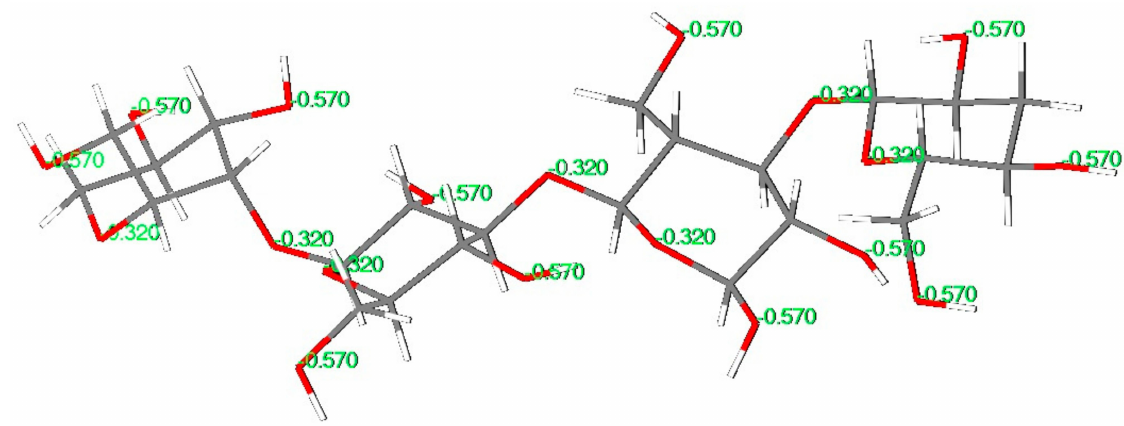
Figure 9. Distribution of the Mulliken charge values of O atoms of the biopolymer molecule CHA.